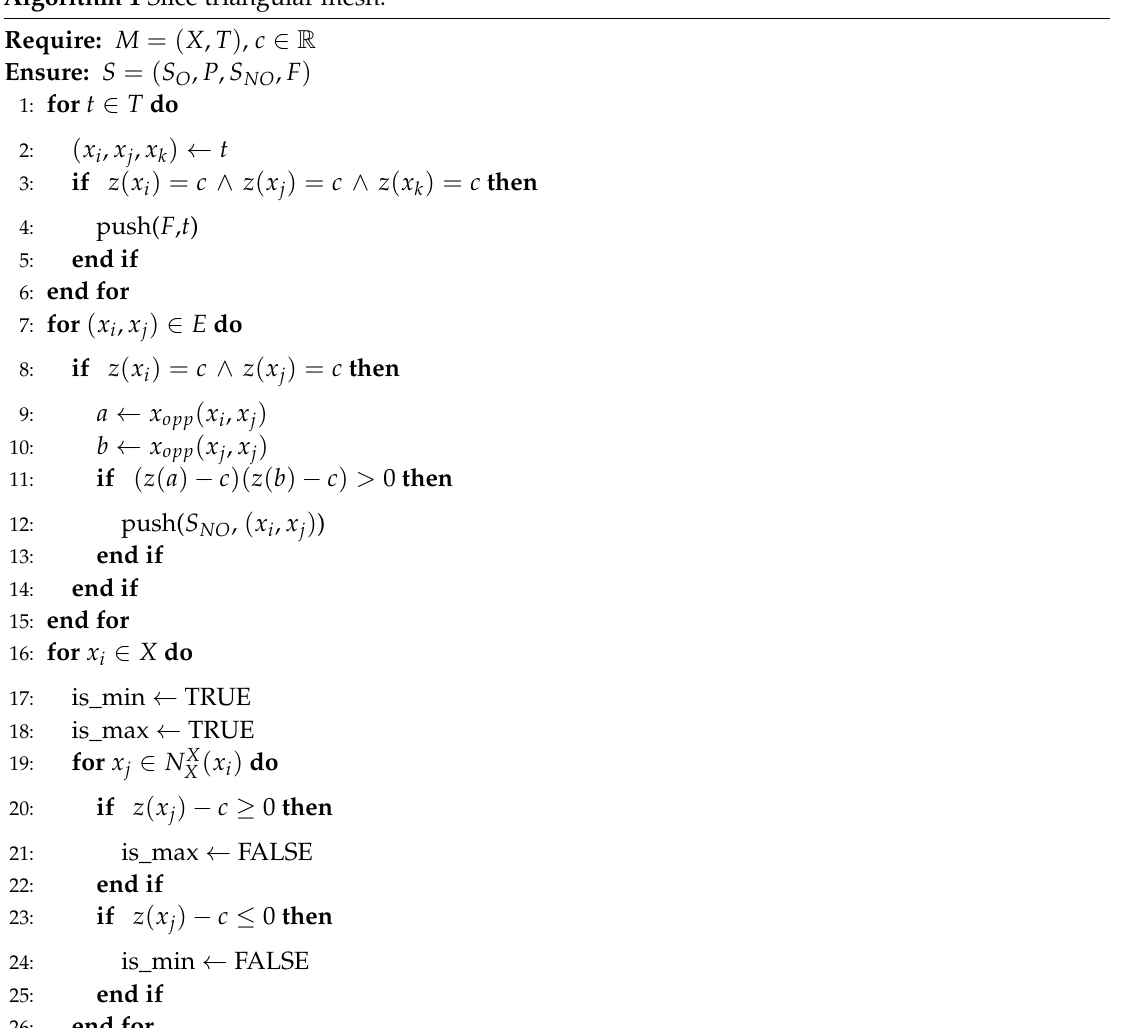
Algorithm 1 Slice triangular